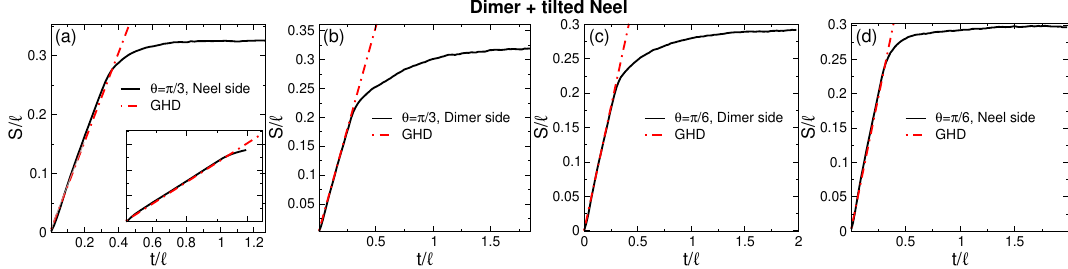
Figure 9: The same as in Fig. 8 for the quench from the state obtained by joining the tilted Néel and the dimer state. The data are for the XXZ chain at ∆ = 2 and for tilting angles θ = π/ 3 (in (a) and (b)) and θ = π/ 6 (in (c) and (d)). The curves show the flea gas results for a subsystem of size (cid:96) = 100 and chain size L = 2000. The data are averaged over ∼ 10000 realizations of the flea gas dynamics. In (a) and (d) the subsystem is placed on the Néel side, whereas in (b) and (c) it is in the dimer side. The dash-dotted lines are the GHD predictions in the space-time scaling